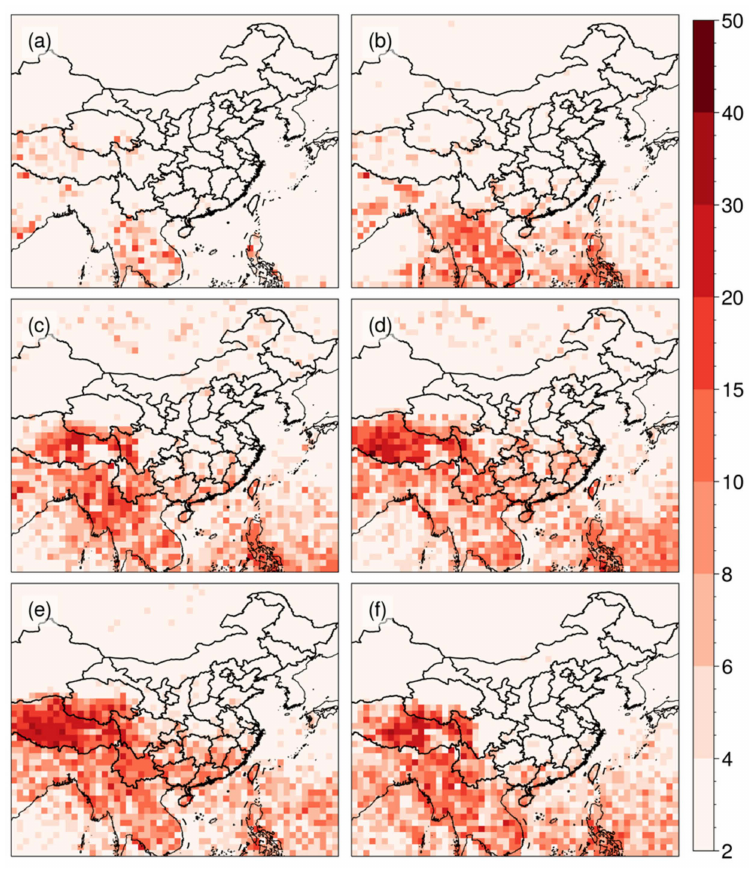
Figure 7. Same as Figure 4, but for deep convective systems initiation